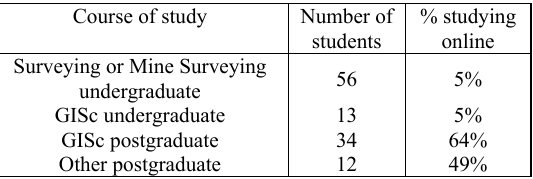
Table 1. Average student numbers in the SpC unit by course of study,